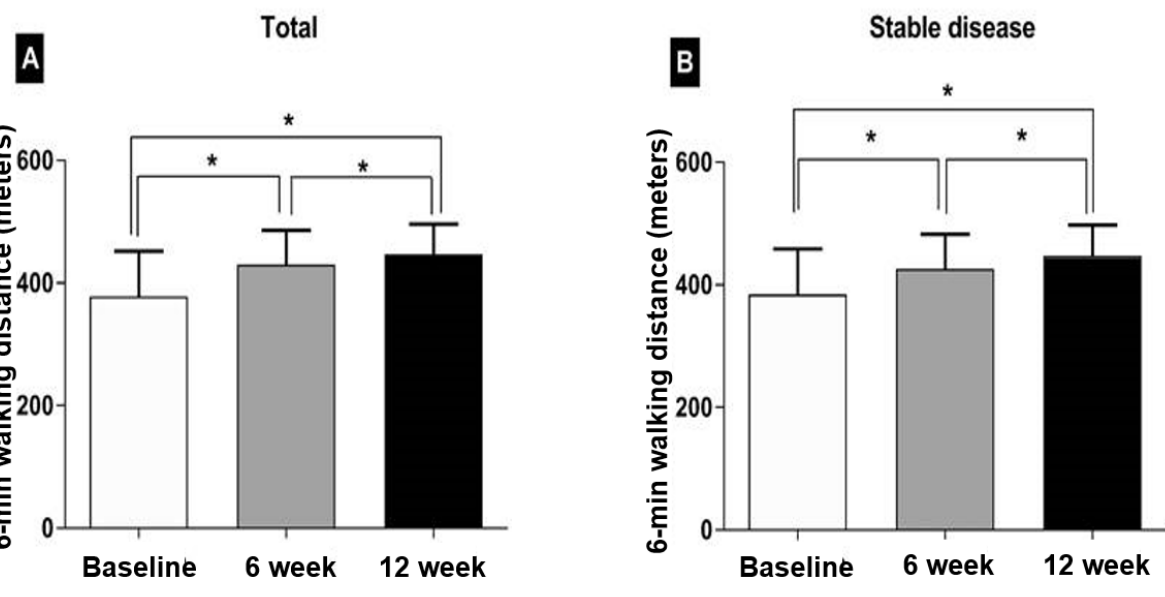
e Disease response was evaluated using response evaluation criteria in solid tumors criteria in patients with stage IV lung cancer. We considered patients with stage II lung cancer to have stable disease status. Figure 1. Exercise capacity. Six-minute walking distance improved significantly after pulmonary rehabilitation in the patients overall (A) and patients with stable tumor response